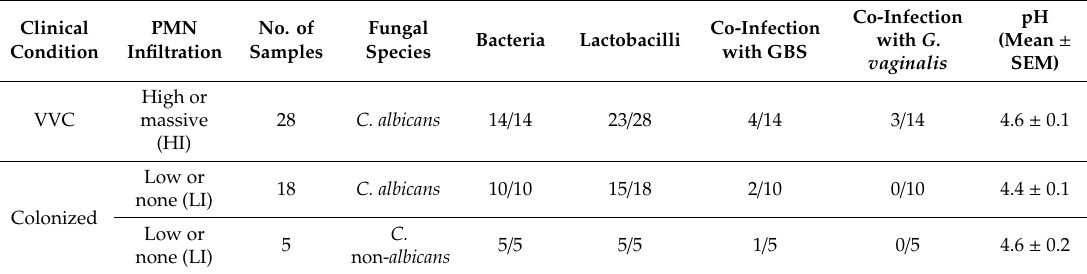
Table 2. Summary of the microbiological features of the vaginal samples